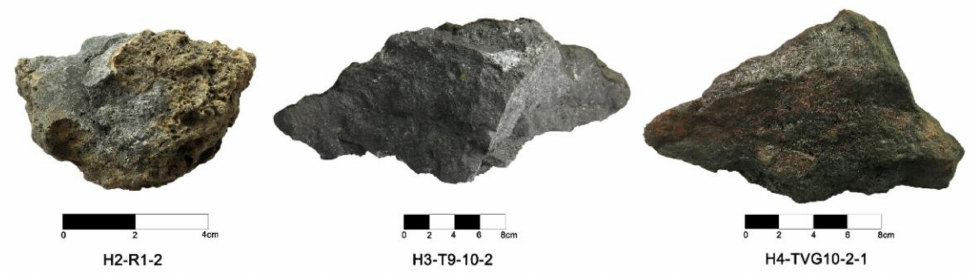
Figure 2. Photographs of hand